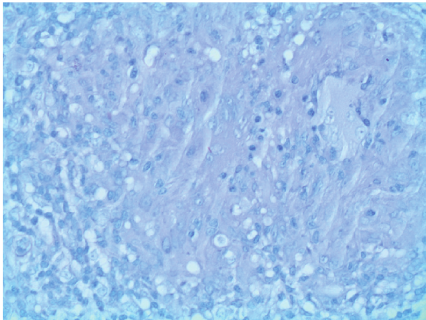
Figure 3: Ziehl-Neelsen stain of synovial biopsy showing acid-fast bacillus (arrow) (400x